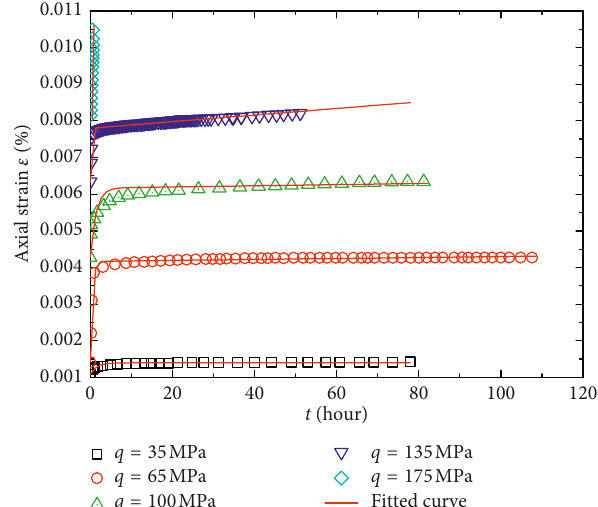
Figure 5: The rheological experiments curve and the fitting results ( σ 3 � 3 MPa, T � 600 ° C).